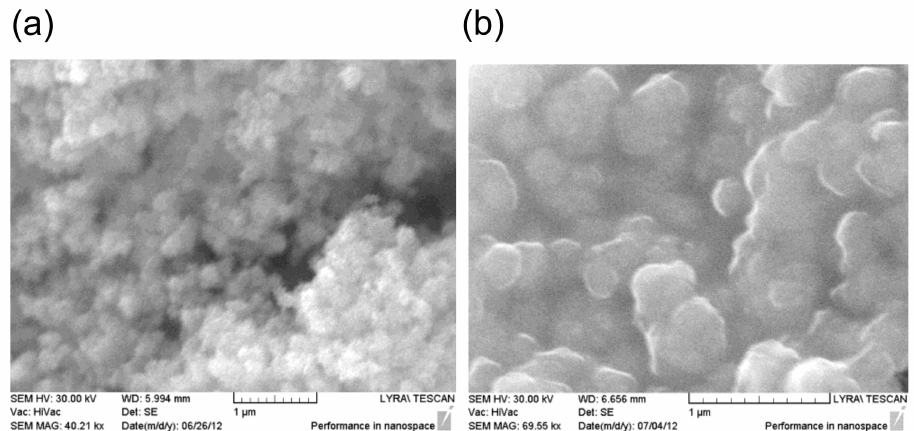
Figure 6. SEM images of particle aggregates obtained at precursor concentration of about 0.66 M TiCl 4 and surfactant concentration of 1 wt % Span 80 in ( a ) hexadecane and ( b ) heavy